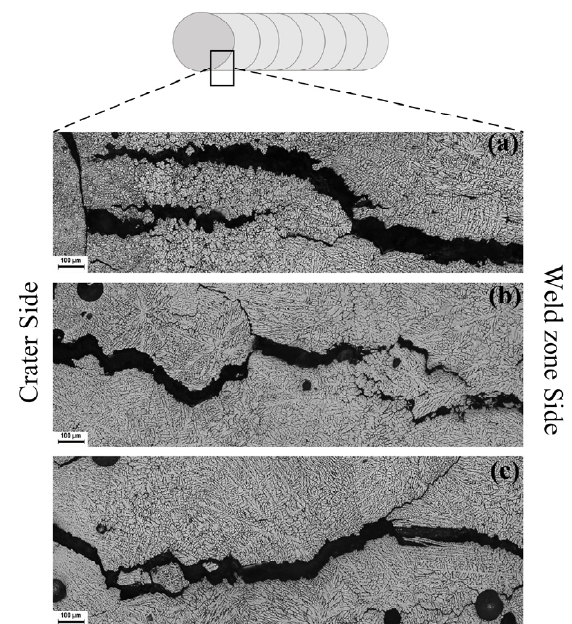
Figure 7. Microstructure adjacent to the crater of the weld (with 7150 filler wire): ( a ) MIG mode; ( b ) CMT mode; ( c ) CMT+P mode.